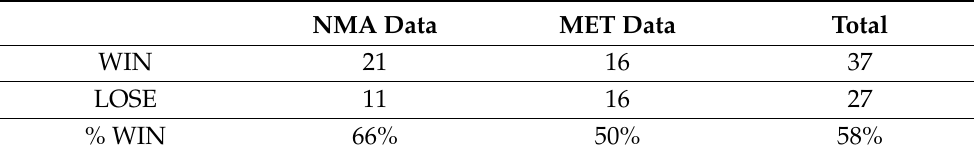
Table 5. Summary of the comparison between AutoNowP and existing